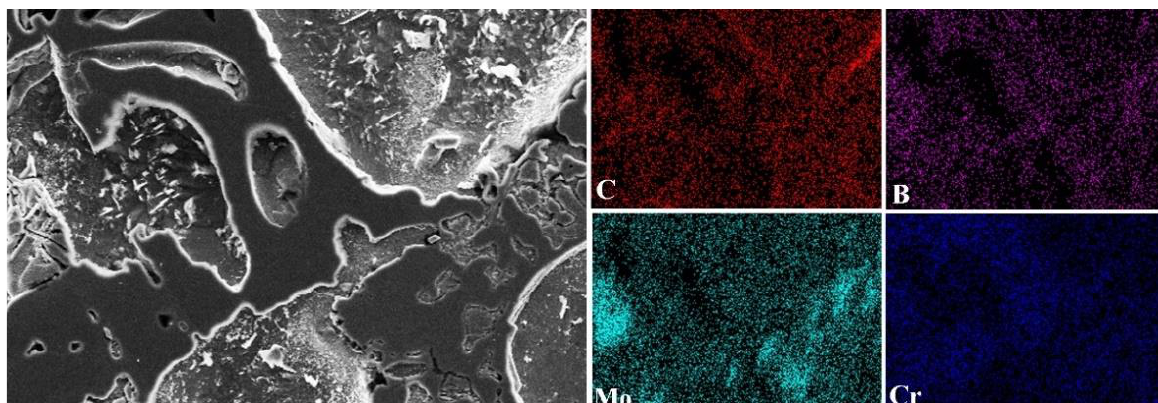
Figure 2. EDS analysis of as-cast alloy A.